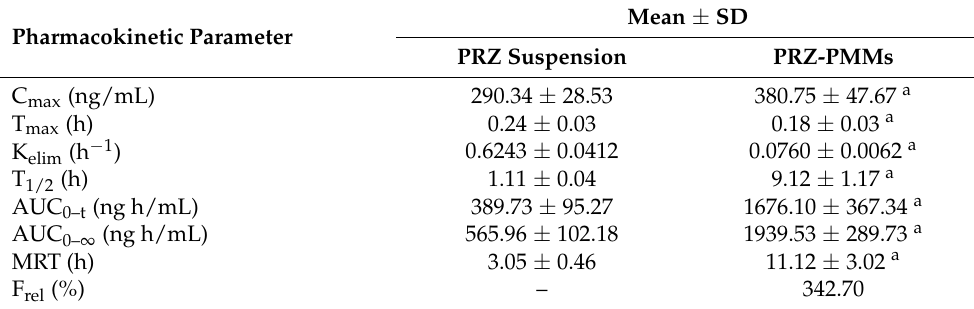
Table 10. Mean pharmacokinetic parameters in rat plasma after a single oral dose (12.5 mg/kg) of PRZ suspension or